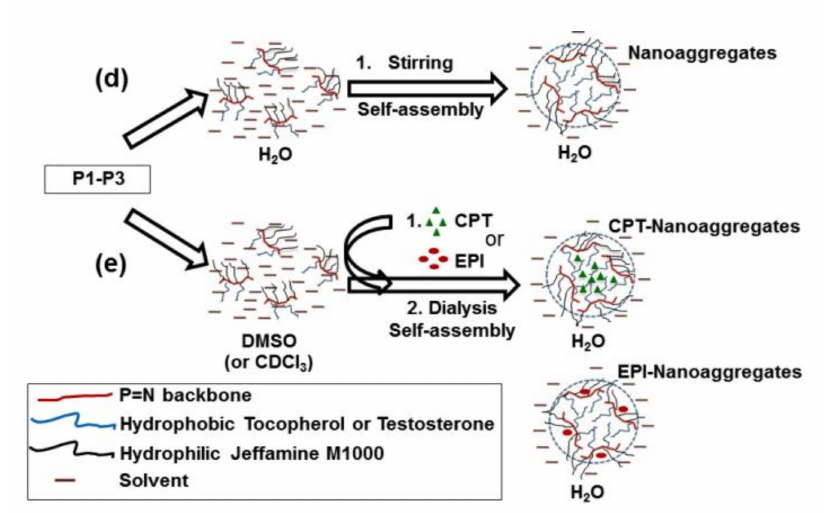
Figure 1. ( a ) Synthesis of tocopherol and testosterone glycinates (ToT-glycine-NH 2 ). ( b ) Polymer- ization of trichlorophosphoranimine to obtain poly(dichloro)phosphazene. ( c ) Post-polymerization functionalization of chlorine atoms with ToT-glycine-NH 2 and Jeffamine M1000. ( d ) Schematic repre- sentation of self-aggregation of polyphosphazenes P1–P3 to form nanoaggregates. ( e ) Encapsulation of CPT and EPI.